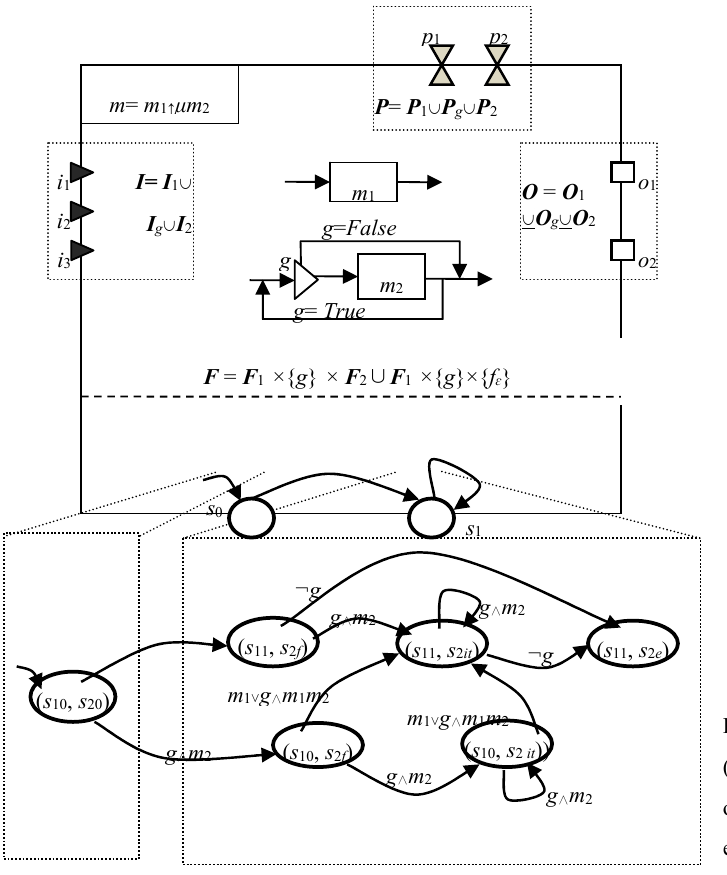
ISPRS Int. J. Geo-Inf. 2017 , 6 , 47 Figure 11. The diagram definition of M ↑ µ M . Figure 11. The diagram definition of M ↑ μ M .